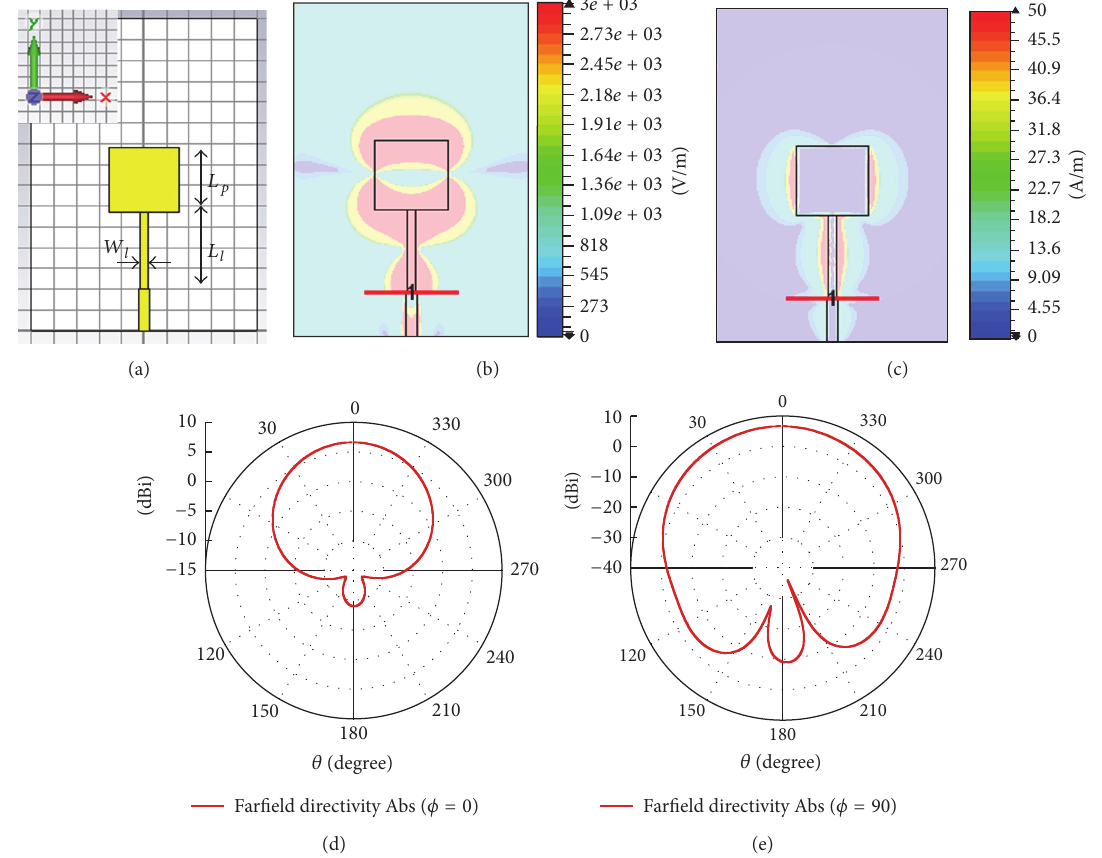
Figure 4: Single-patch geometry (a); 𝐸 𝑧 field distribution (b) and 𝐻 𝑧 field distribution (c) on the patch plane ( x - y ); sagittal ( x - z ) (d) and azimuthal ( y - z ) (e) radiation